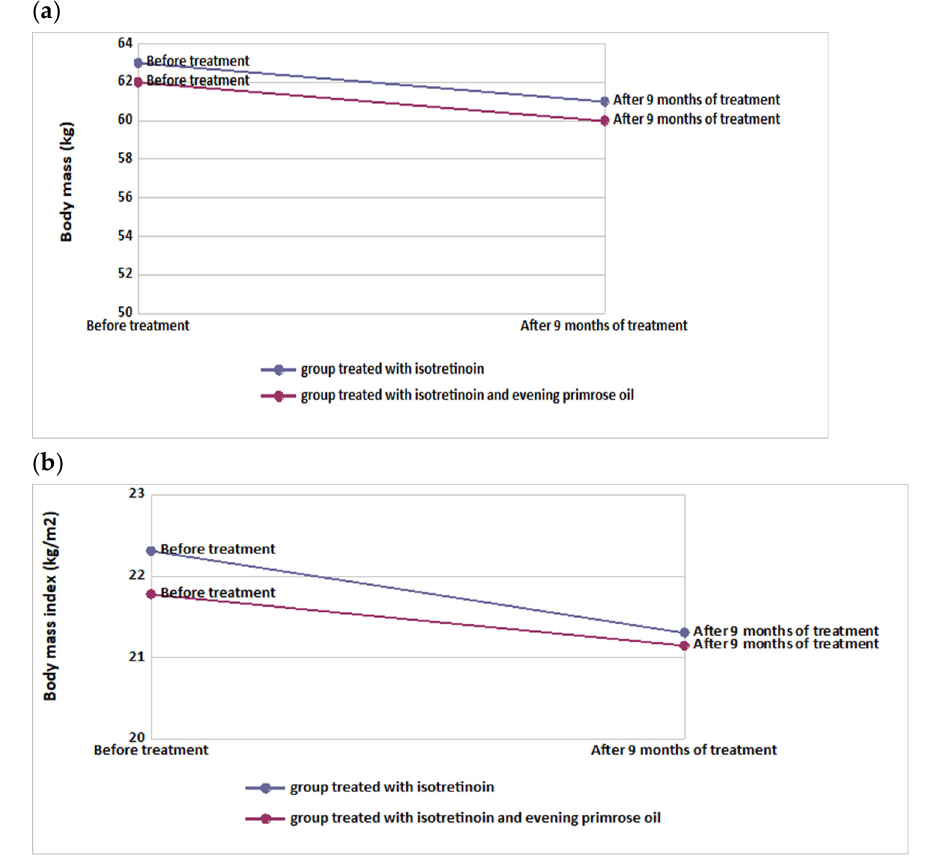
Figure 3. Changes in body weight ( a ) and BMI ( b ) in groups using isotretinoin or isotretinoin with evening primrose oil.